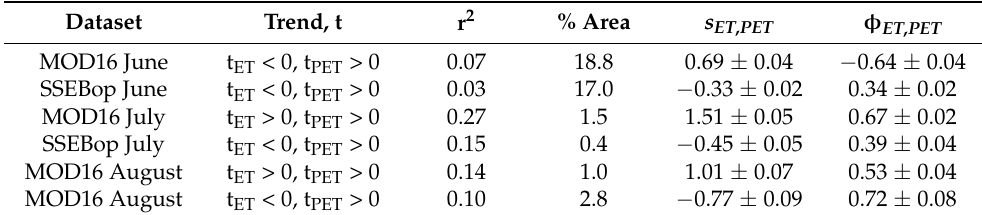
Table 7. Monthly correlation and sensitivity analysis between PET and ET trends. The spatial extent of the area that originated these results is expressed as a percentage of the area with positive or negative ET trends (% area). s and φ are the slope of the linear regression and the average impact of the trend of PET on the trend of ET, with their respective uncertainties. p -value < 0.001 for all the estimated correlation